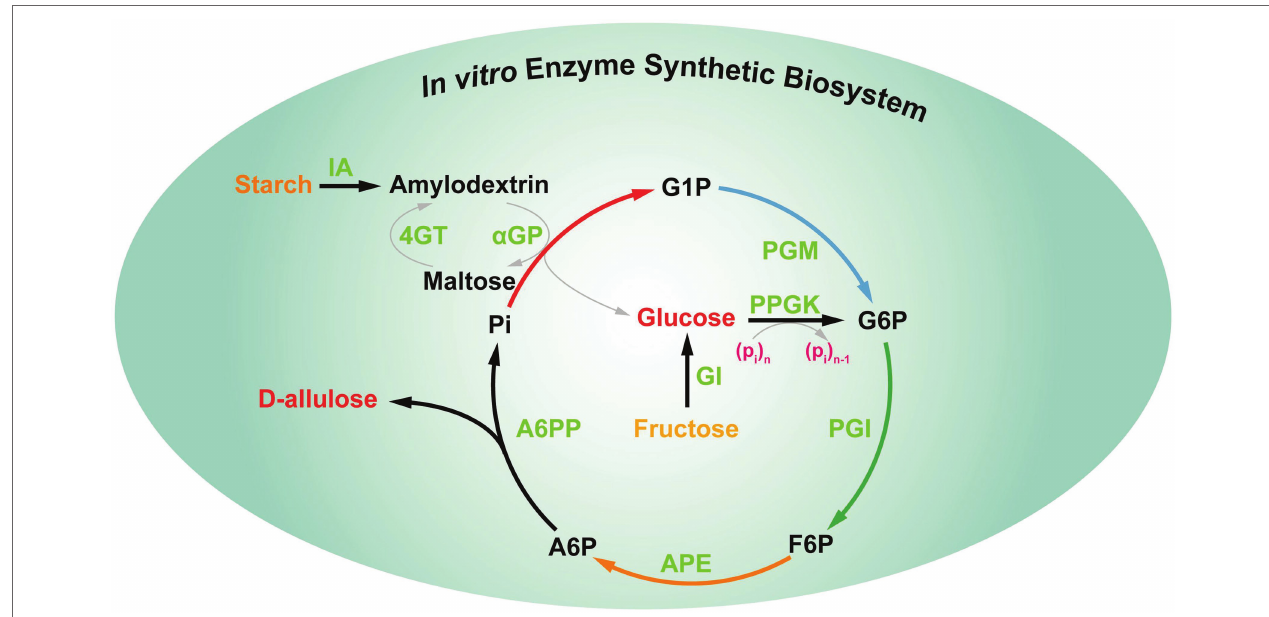
FIGURE 9 | In vitro multi-enzyme synthesis of D-allulose from starch. IA, isoamylase; 4GT, 4- α -glucanotransferase; α GP, α -glucan phosphorylase; PGM, phosphoglucomutase; PPGK, polyphosphate glucokinase; PGI, phosphoglucose isomerase; GI, glucose isomerase; APE, D-allulose 6-phosphate 3-epimerase; A6PP, D-allulose 6-phosphate phosphatase; G1P, glucose-1-phosphate; G6P, glucose-6-phosphate; F6P, fructose-6-phosphate; A6P,